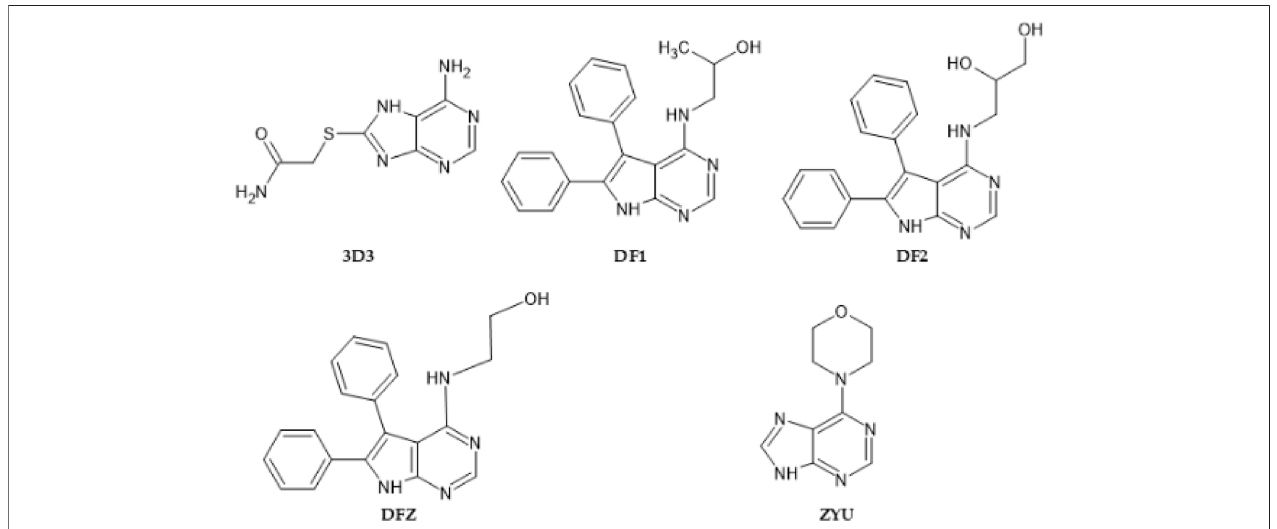
FIGURE 4 | 2D structures of native ligands complexed with Chk1 protein structures retrieved from PDB.